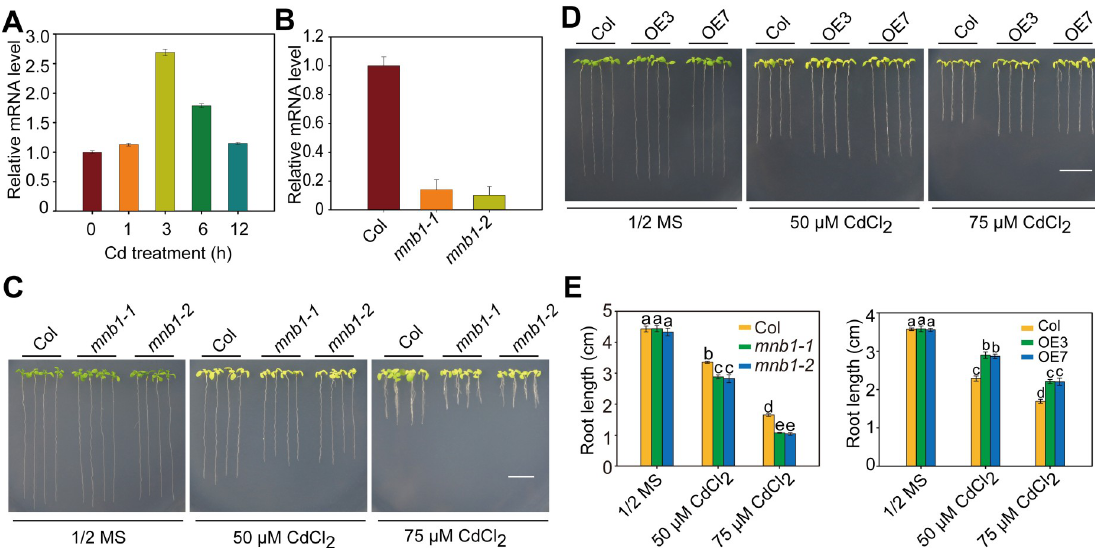
Fig 1. MNB1 positively regulates Cd tolerance. (A) Expression of MNB1 in response to Cd stress. Two-week-old wild-type plants grown on 1/2 MS media were treated with 50 μ M CdCl 2 for 0, 1, 3, 6, 12 h before the tissues were harvested for RT-qPCR analysis. GAPDH was used as an internal control. Data are presented as means ± SD of three biological replicates. (B) RT-qPCR analysis of MNB1 transcript level in Col and mnb1 mutants. GAPDH was used as an internal control. Data are presented as means ± SD of three biological replicates. (C, D) Cd stress phenotypes of Col, mnb1 mutants (C), MNB1-OE (D) seedlings. Three-day-old seedlings grown on 1/2 MS medium were transferred to 1/2 MS medium with or without 50 or 75 μ M CdCl 2 for 2 weeks. Scale bar = 1 cm. (E) Root length of plants described in C and D. Three independent experiments were done with similar results, each with three biological replicates. Four plants per genotype from one plate were measured for each replicate. Data are presented as means ± SD, n = 3. Bars with different lowercase letters are significantly different at P < 0.05 (Tukey’s